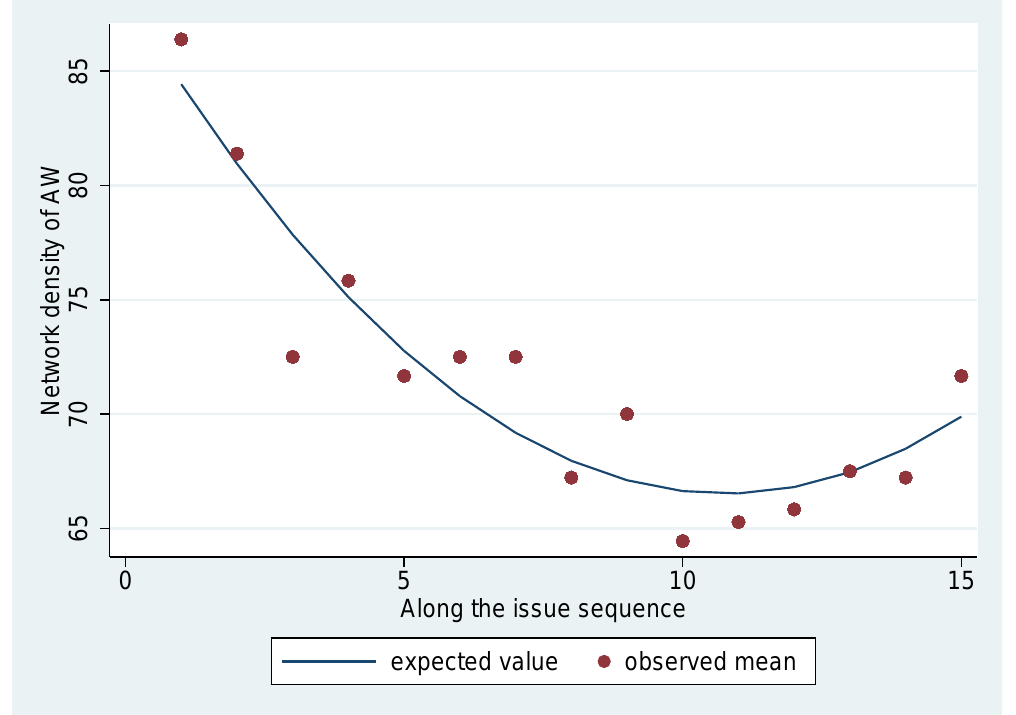
Figure 11: Evolution of the network density of AW . Density scaled 0 − 100%. Balanced random-intercept fixed effects longitudinal design; STATA 12 xtreg implementation; n = 450. Plot of expected values based on the estimated β constant = 88.284 (s.e. = 3.075), p ≤ 0.001; β s = − 4.043 (s.e. = 0.884), p ≤ 0.001, β